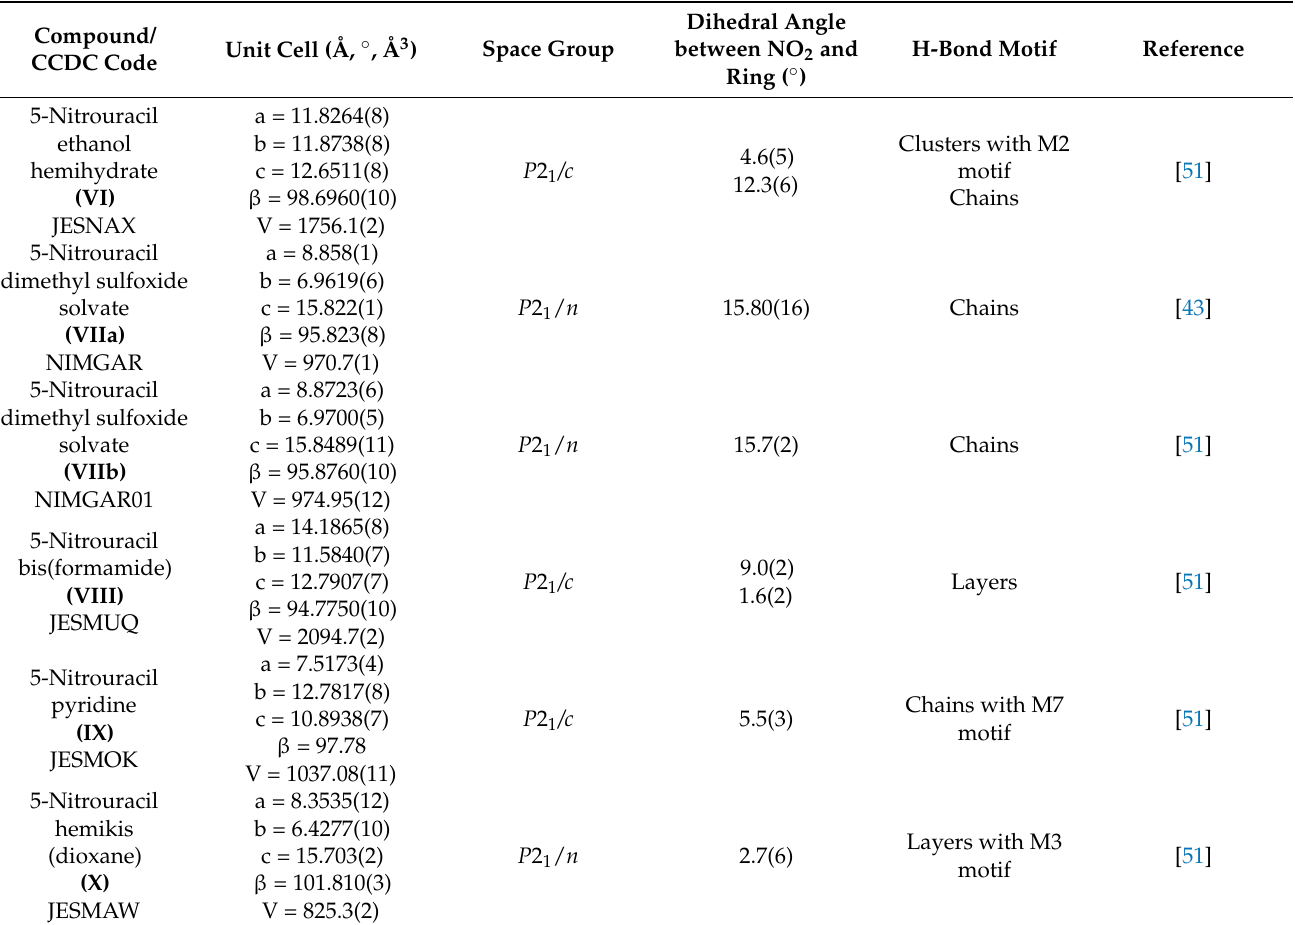
Table 4. Crystallographic data of 5NU